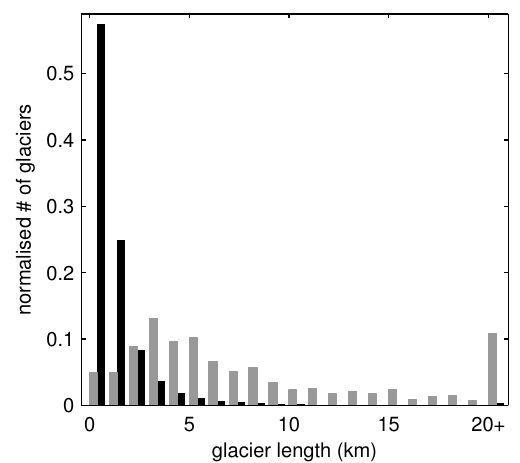
Fig. 6. Normalized distribution of glacier length in the glacier length fluctuations data set ( L 1950 , grey) and the WGI (black). The right- most bar of both data sets gives the relative number of glaciers with a length larger than 20